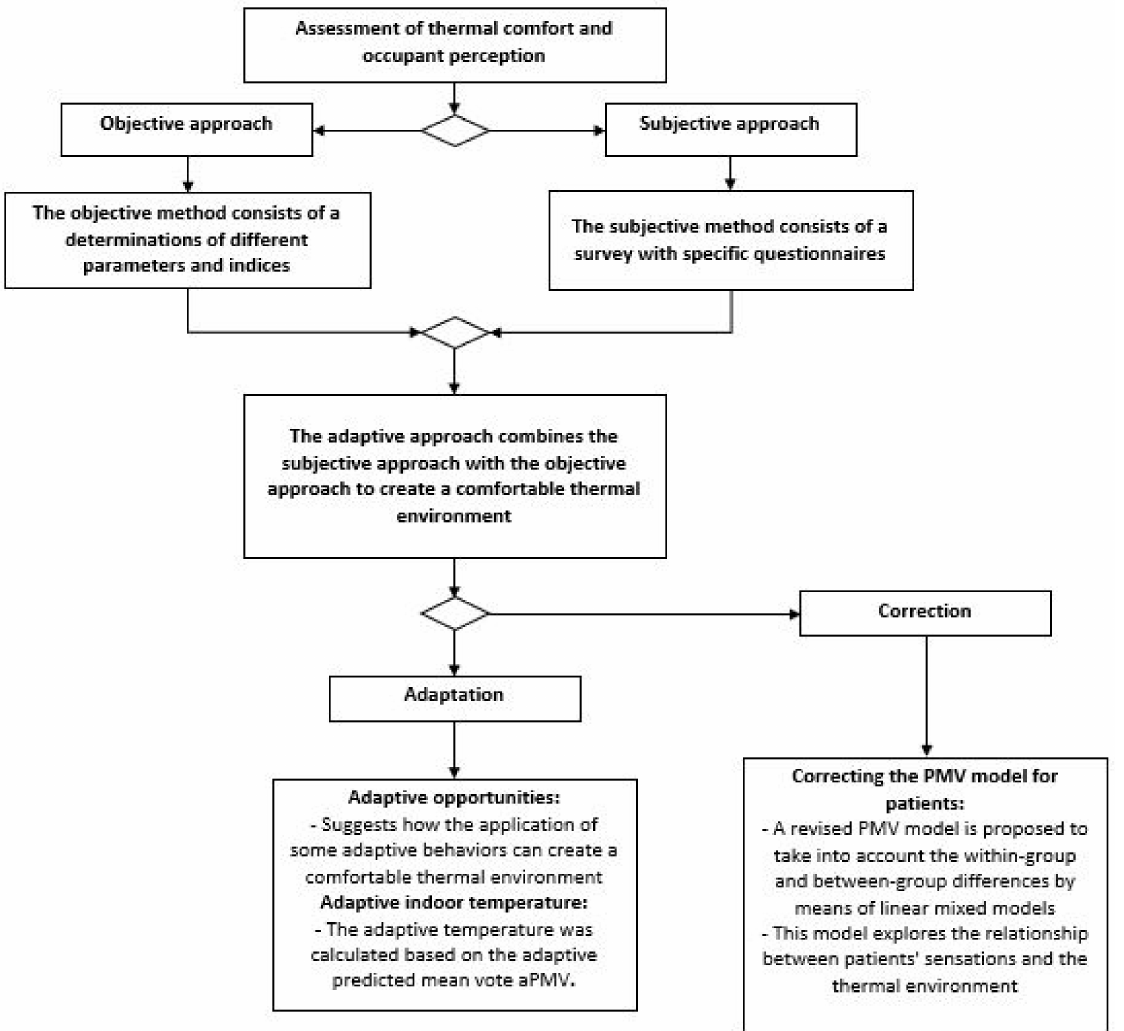
Figure 1. Proposed research